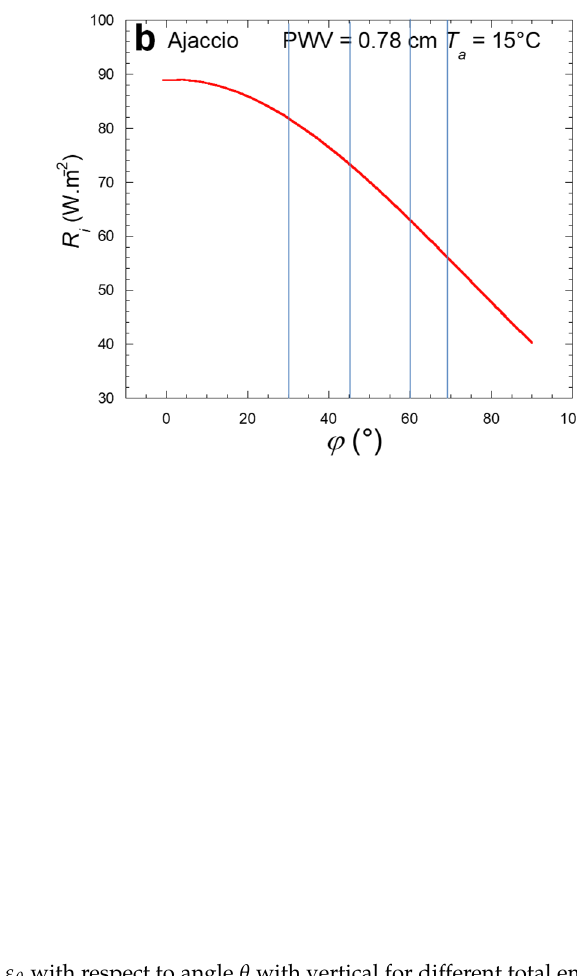
Figure 6. ( a ) Directional emissivity ε θ with respect to angle θ with vertical for different total emissivities ε s (Equation (11) with b = 1.8). The interrupted vertical lines (A) corresponds to the influence of the nearby vehicle in the NNE direction, with emissivity near unity. The double interrupted vertical line (B) corresponds to the influence of the nearby buildings in nearly all directions, with emissivity near unity. The continuous vertical lines (C) corresponds to the limiting sky views related to the windows tilt angles ϕ . ( b ) Variation with tilt angle ϕ of radiation deficit in Ajaccio at T = 15 ◦ C with no obstacles, corresponding to the precipitable water vapor PWV = 0.78 cm (data interpolated from [31]). The vertical lines correspond to the window’s tilt angles. ( c ) Variation with respect to the tilt angle of the relative radiative deficit R i ( α , ϕ ) / R i ( 0,0 ) at various obstacle view angles α (data interpolated from